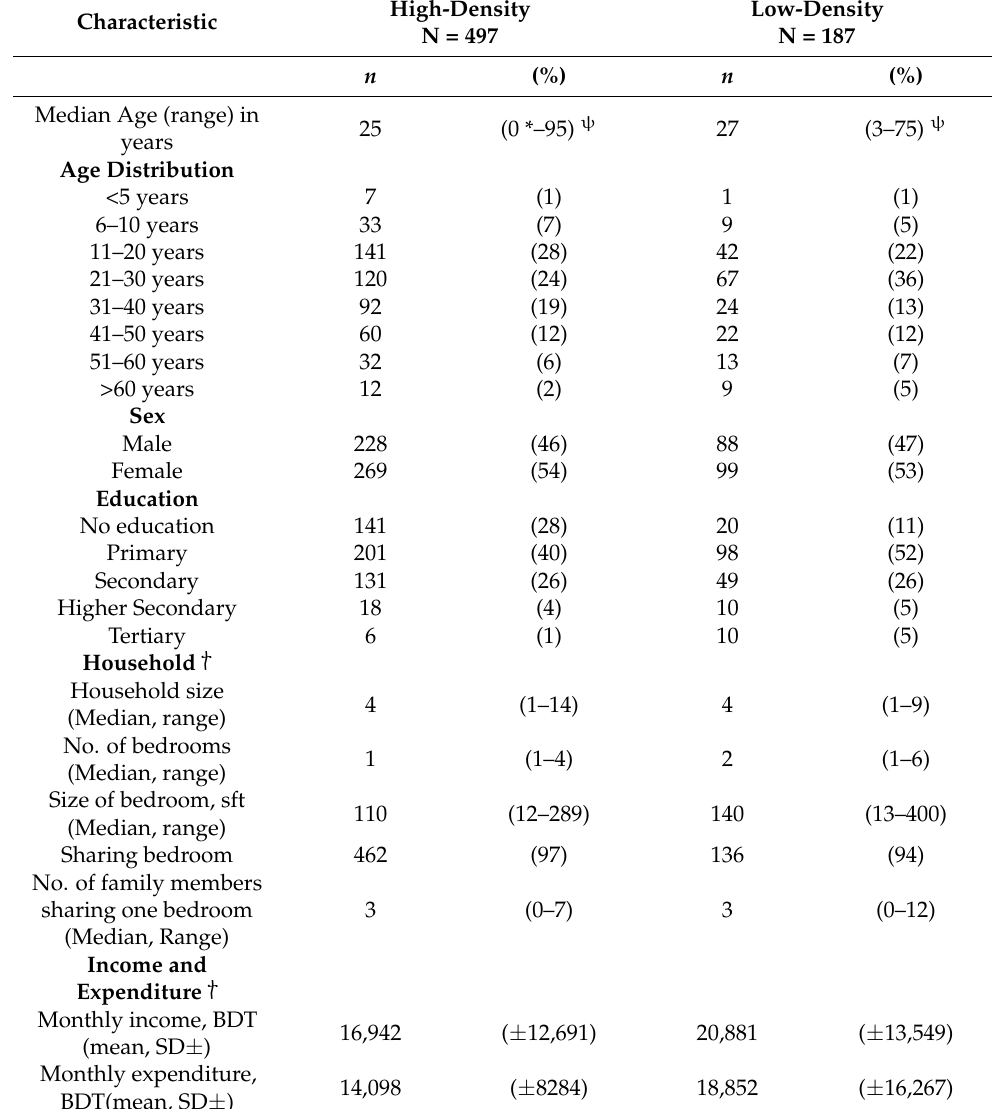
Table 3. Estimation of the basic reproduction number (Ro) in high-density and low-density areas in Dhaka city.